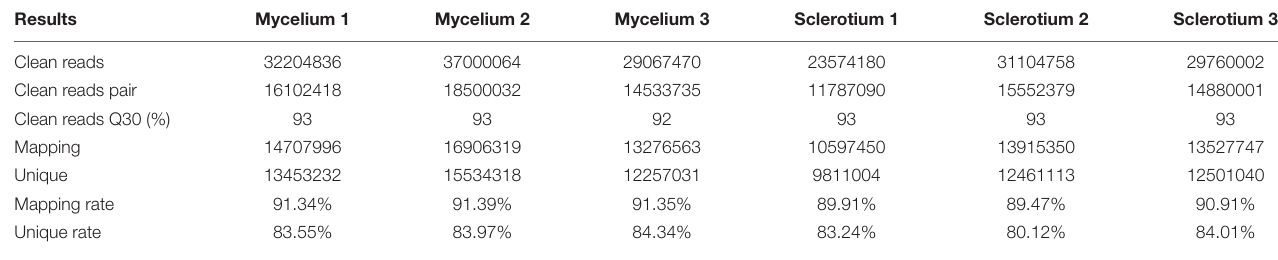
TABLE 2 | Transcriptome output and assembly data of mycelia and sclerotia samples in triplicate.